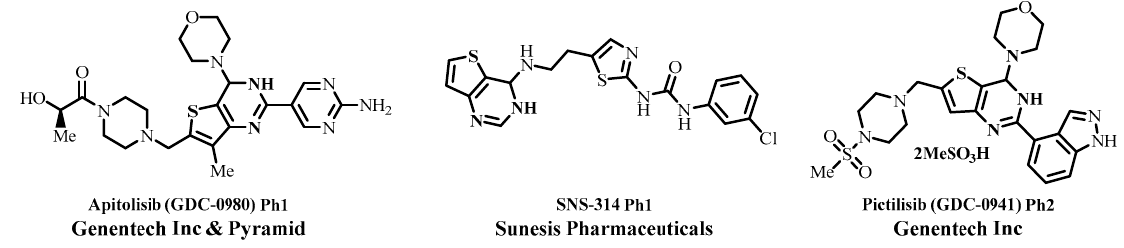
Figure 1. Structure of potent thienopyrimidine-based lead compounds developed by pharmaceutical companies worldwide.